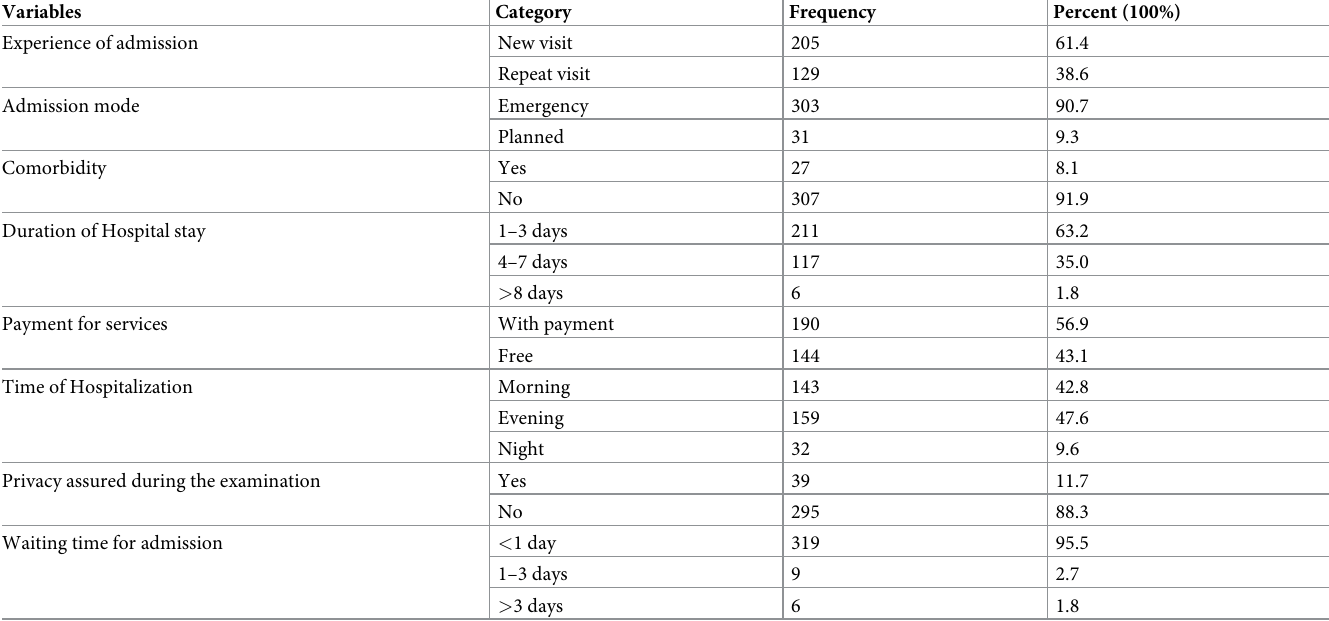
Table 2. Patient-related factors of inpatient services at Pawie General Hospital Benishangul Gumuze Region, West Ethiopia, 2020 (n =